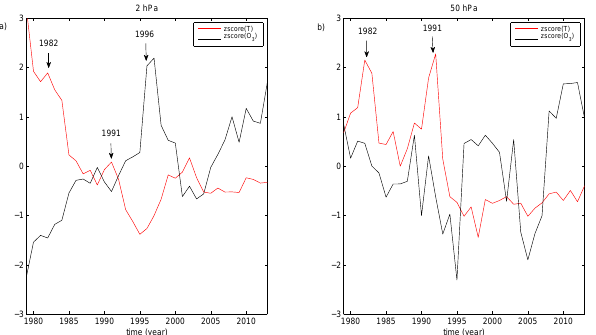
Figure 3. Time series of annual-mean, global-mean (area-weighted) standardized anomalies of O 3 and T ( z scores) at (a) 2hPa and (b) 50hPa. Arrows denote the starting year of GOME data assimila- tion into the reanalysis system (1996) and the major volcanic erup- tions (El Chichón in 1982 and Pinatubo in 1991).